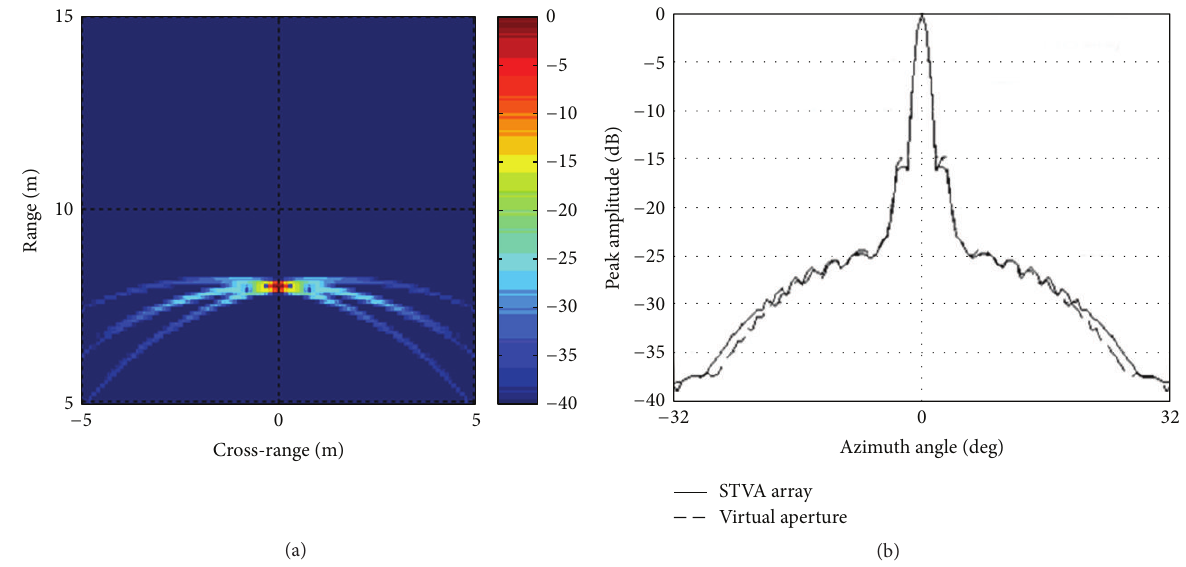
Figure 5: Imaging results of the STVA array with Hamming function in frequency. (a) Imaging result. (b) Peak amplitude pattern in azimuth angle.